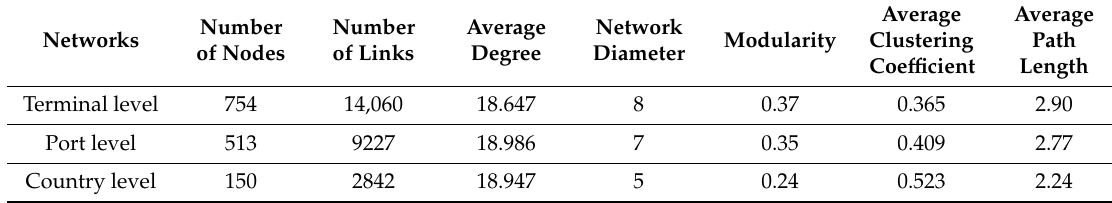
Table 1. Characteristics of three different levels of global container networks.